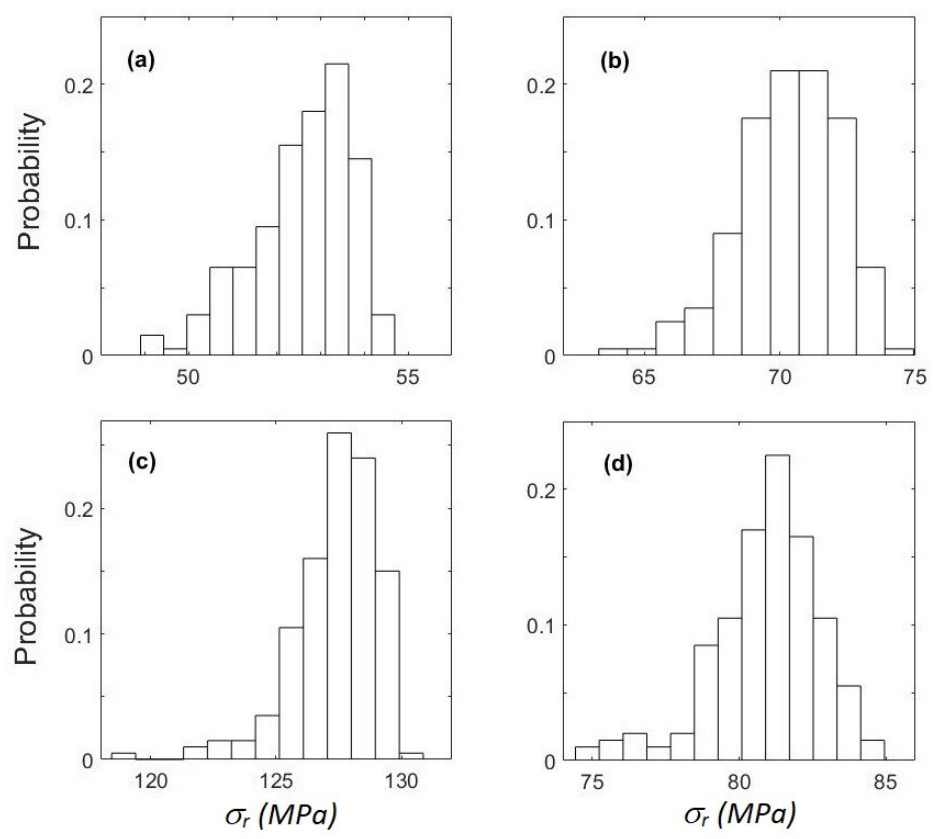
Figure 4. Examples of histograms of strength σ r for di ff erent m -values. ( a ) m = 6; ( b ) m = 10; ( c ) m = 50. ( d ) Histogram obtained for arbitrarily modified values of some parameters in Equation (3) describing the coupling between the plastic flow and stress on the particles ( m = 10).